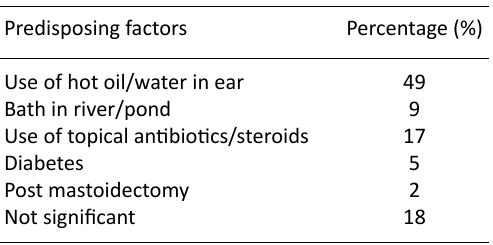
Table 5. Different fungi isolated from study